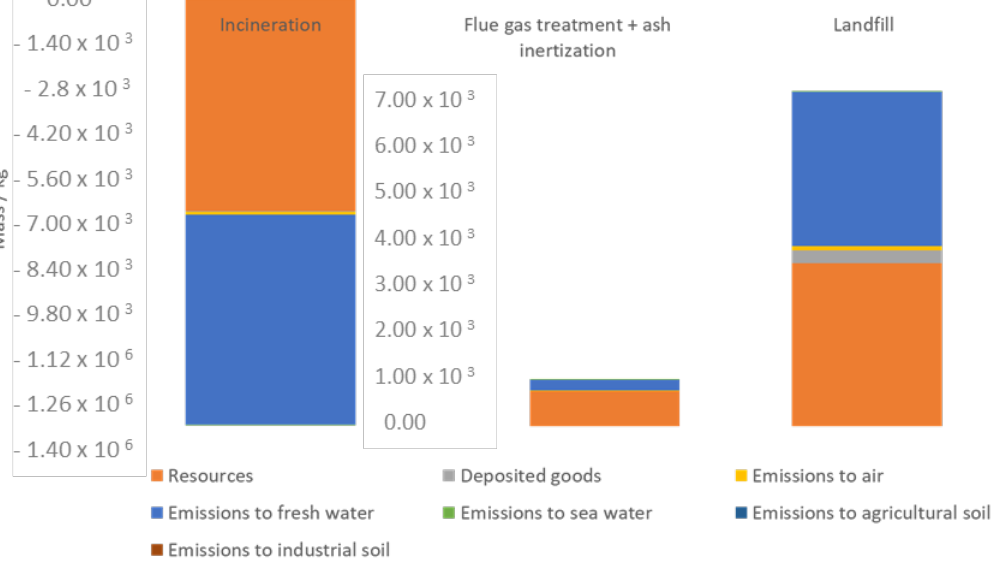
Figure 16. Environmental impact of the incineration processes in the Portuguese case study. Results refer to one tonne of treated residues.